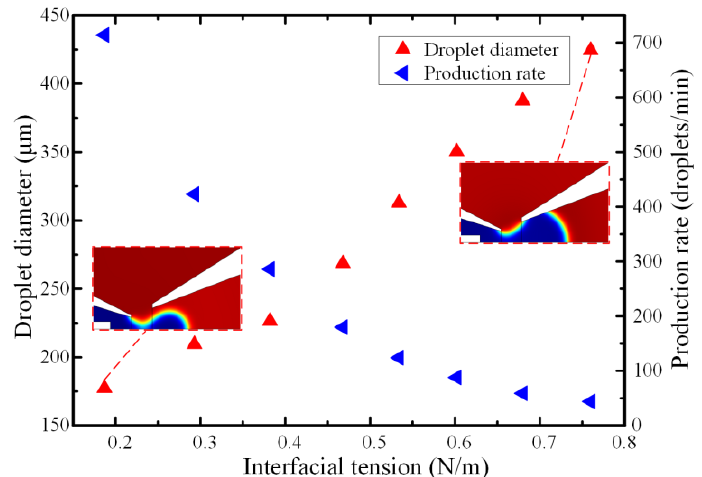
Figure 6. The effect of interfacial tension on the droplet diameter and generation frequency when the flowrate of continuous and dispersed phases were 100 μL/min and 10 μL/min, respectively .